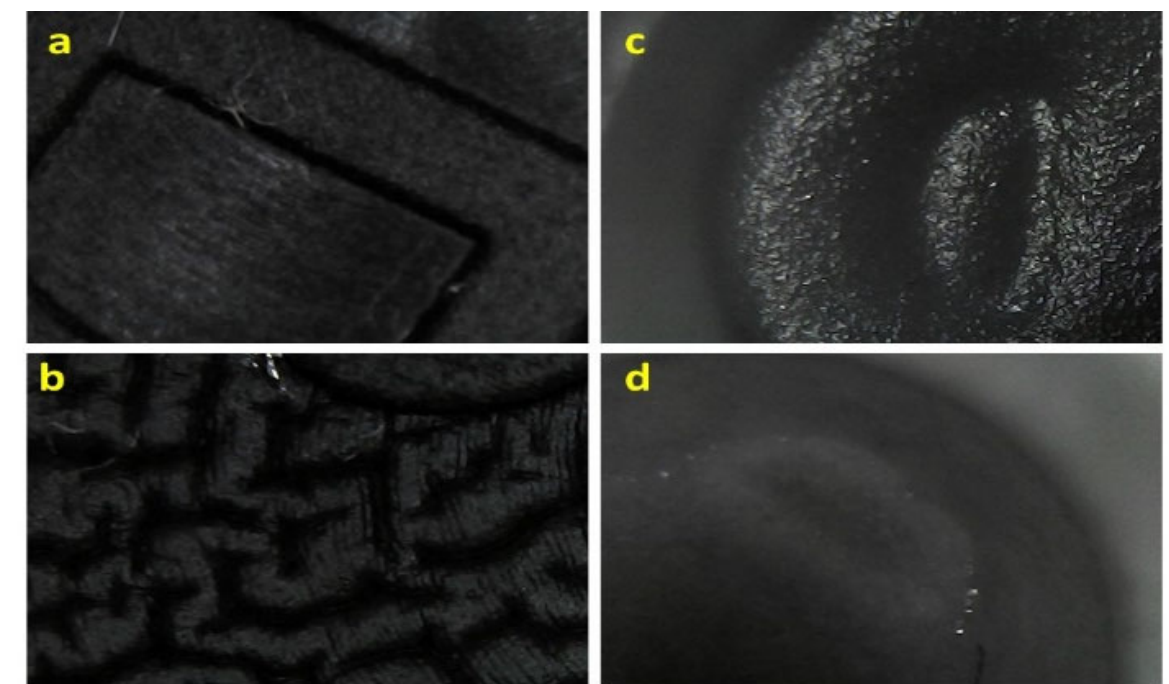
Figure 4. Micrographs obtained with a digital microscope at 200 × magnification. Key: ( a ) JEA at time zero; ( b ) JEA after 36 months of exposition to the midazolam solution; ( c ) JEN at time zero; ( d ) JEN after 36 months of exposition to the midazolam solution.